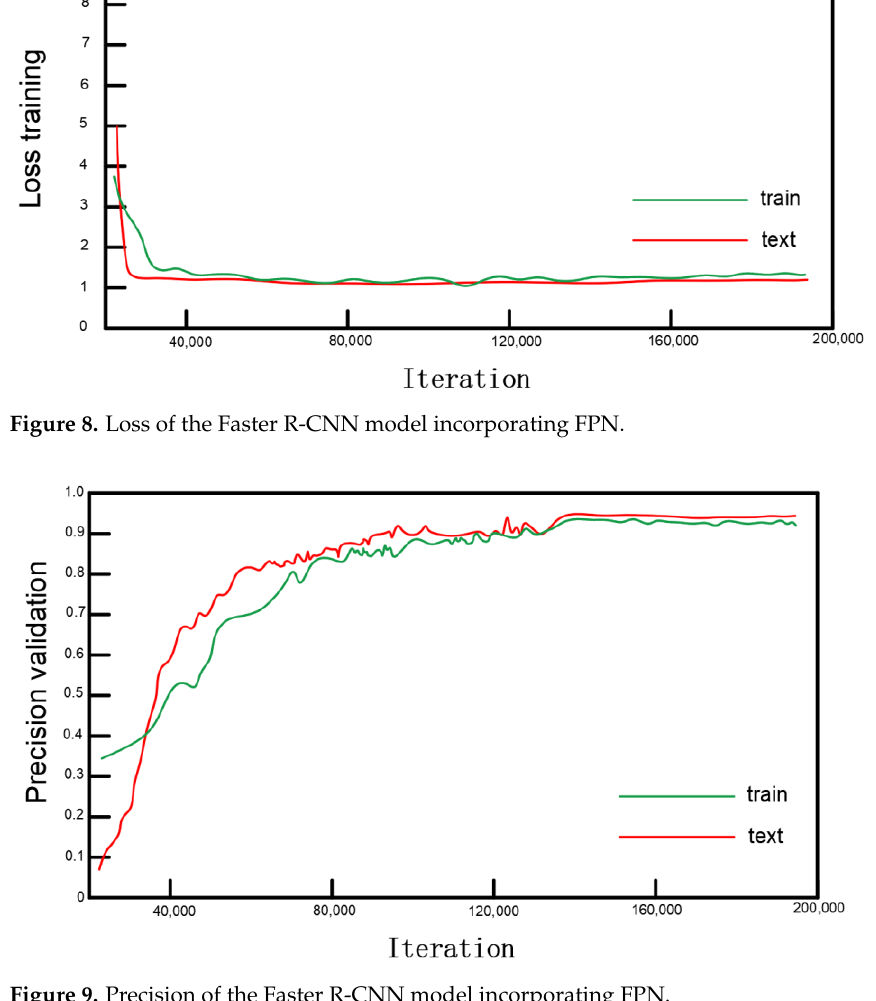
Figure 9 . Precision of the Faster R-CNN model incorporating FPN.